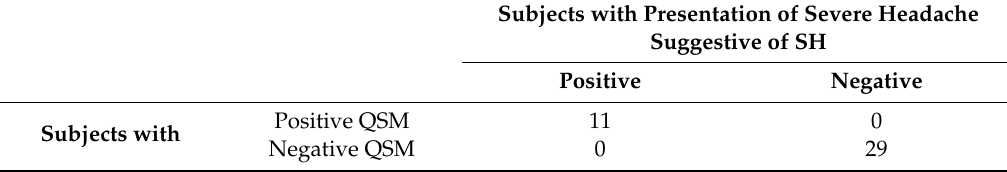
Table 2. Relationship between microbleed detected by quantitative susceptibility mapping (QSM) and presentation of severe headache suggestive of